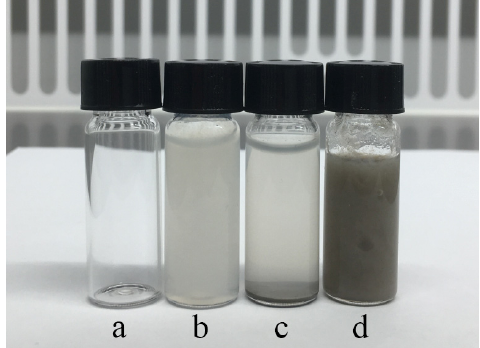
Figure 12. Photos (from left to right): an empty glass container ( a ), aqueous 0.5% BC dispersion ( b ), 0.5% aqueous dispersion of nanodiamonds ( c ) and mixed aqueous dispersion of 0.5% BC + 0.5% nanodiamonds ( d